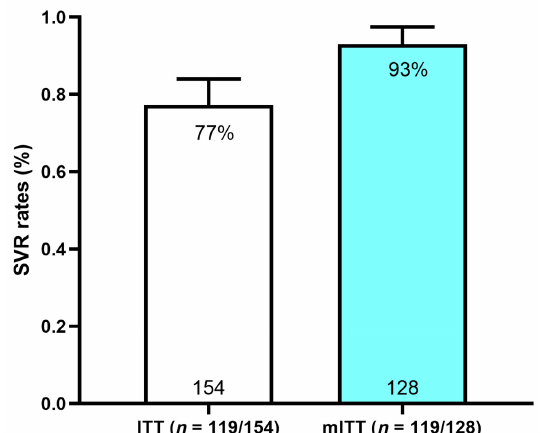
Figure 2. SVR12 rates in ITT and mITT populations. SVR: sustained virologic response; ITT: intention-to-treat; mITT: modified intention-to-treat. Baseline characteristics that were associated with the SVR are presented in Table 2 (for the ITT and mITT populations). In a multivariate analysis for the ITT population, the employment (with an odds ratio (OR): 2.79, 95% confidence interval (CI): (1.15–6.79), p = 0.02) and APRI ≥ 2 (OR 0.26, (0.07–0.88), p = 0.03) were independently associated with SVR. Table 2. Predictors of SVR12 (ITT and mITT); adjusted odds ratio presented.